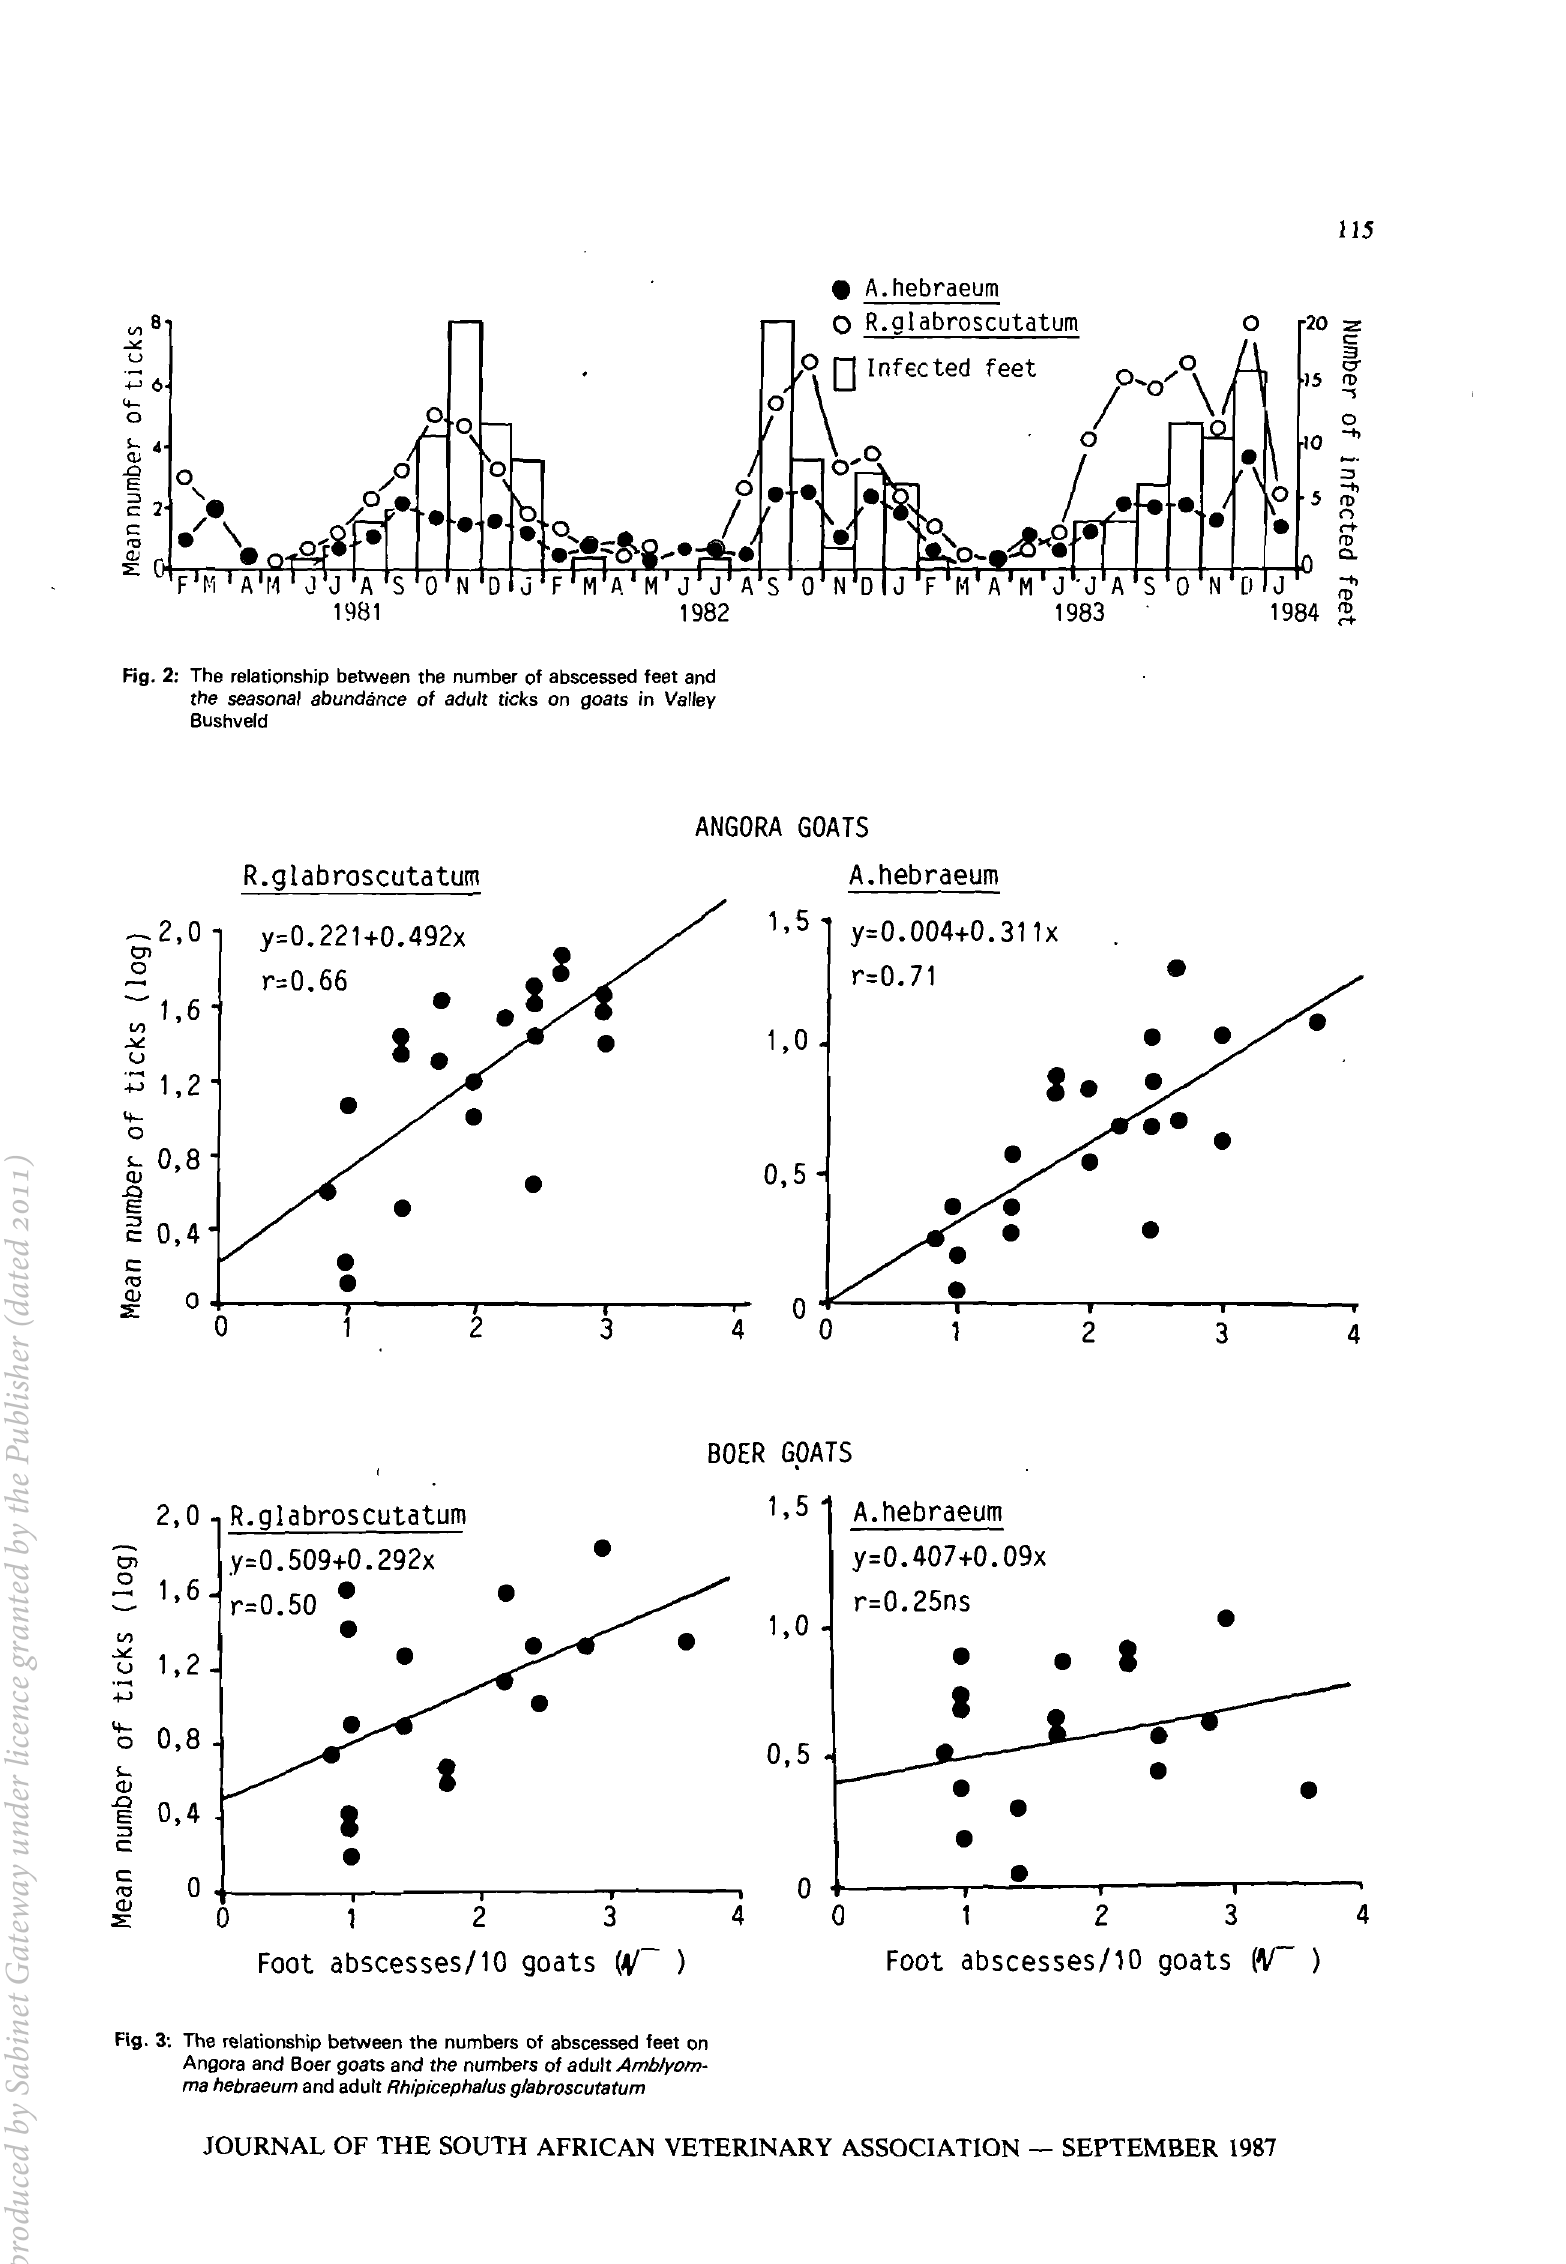
Fig. 3: The relationship between the numbers of abscessed feet on Angora and Boer goats and the numbers of adult